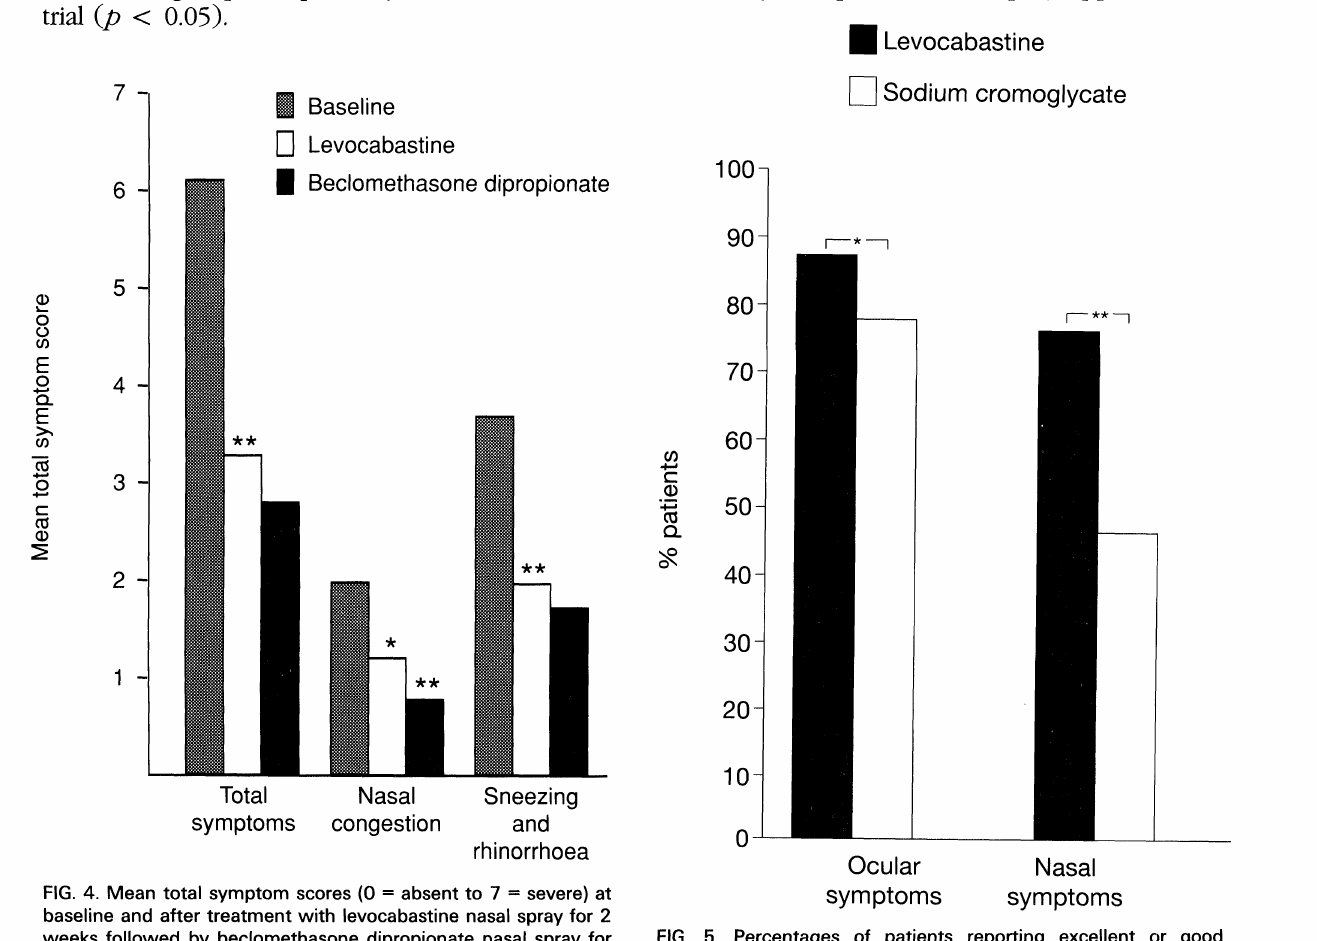
FIG. 4. Mean total symptom scores (0 absent to 7 severe) at baseline and after treatment with levocabastine nasal spray for 2 weeks followed by beclomethasone dipropionate nasal spray for duced with the kind permission of Munksgaard Int. Publishers Ltd, Copenhagen, Denmark.